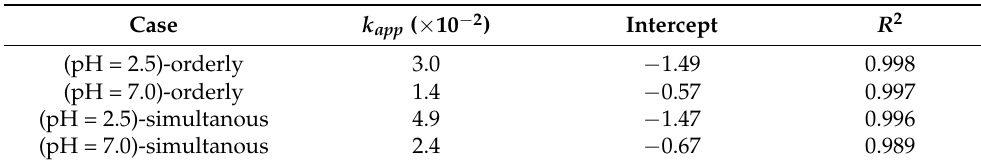
Table 2. The parameters of the linear fitting in Figure